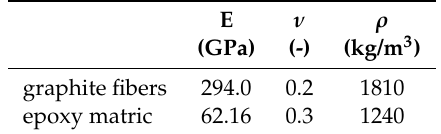
Table 1. Material properties of graphite fibers and epoxy matrix.